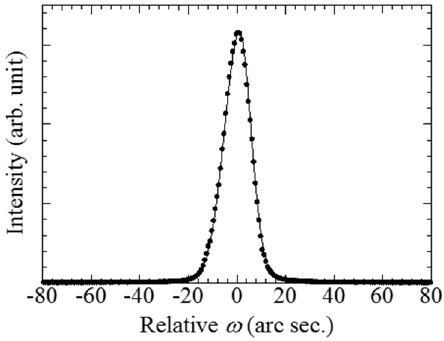
( b ) Figure 2. High-resolution 2 θ — ω scan results with various sample temperatures measured around ( a ) 00 , 024 and ( b ) 11-218 diffraction peaks of SCAM single crystal. Figure 3 shows the temperature dependence of the a - and c -axes lattice parameters for a SCAM single crystal, and Table 1 summarizes each lattice parameter. The estimated errors of the lattice parameters are about ±0.00002 nm for all conditions due to the high angular resolution analyzer optics geometry [13]. The obtained lattice parameters of a - and c -axes are 0.32426(2) nm and 2.50850(2) nm at room temperature, and they are about 0.20% larger and 0.26% shorter than the published parameters a = 0.3236 nm and c = 2.515 nm, respectively [14]. The temperature dependences of both lattice parameters were smooth and no phase transition related glitches were observed. To our knowledge, there is no structural phase transition in SCAM crystals for this temperature range. In Figure 3, each dependence of the lattice parameters plotted against the temperature (Celsius; °C) was fitted by quadratic functions as follows: a (nm) = 4.6207 × 10 − 10 T 2 + 1.8978 × 10 − 6 T + 0.32418 and c (nm) = 1.2355 × 10 − 9 T 2 + 3.1700 × 10 − 7 T + 2.5076. These functions clearly show the lattice parameters at 0 °C ( a 0 and c 0 ), that is, a 0 = 0.32418 nm and c 0 = 2.5076 nm. 93.0